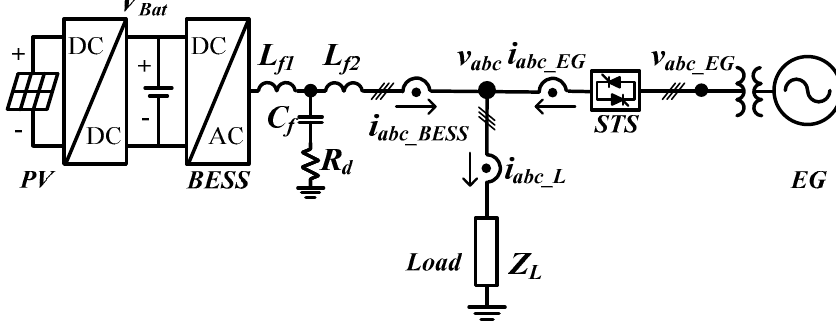
Figure 1. System configuration of a battery energy storage system (BESS) connected to a load generator.